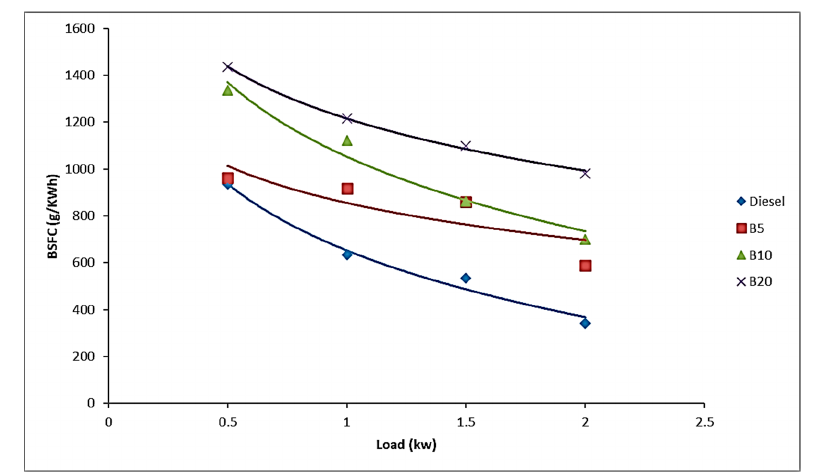
Figure 8. Variation in BSFC with respect to